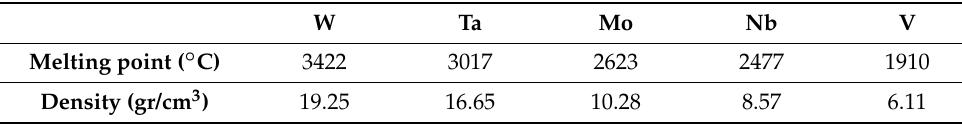
Table 1. Typical physical properties of the considered refractory